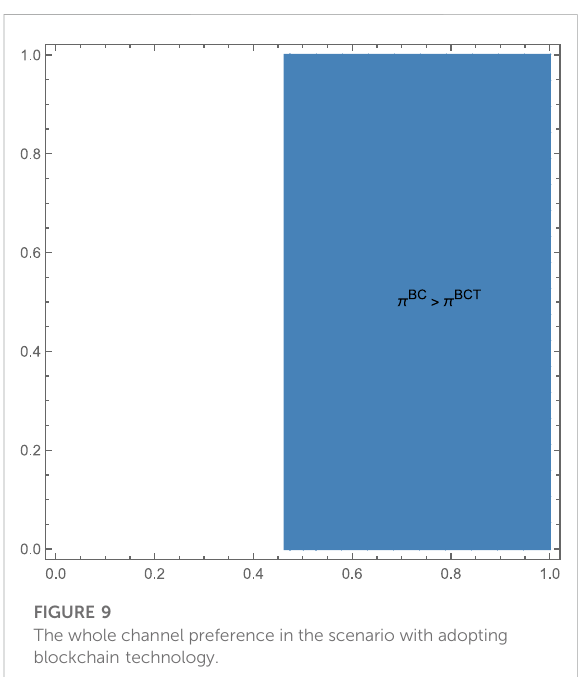
FIGURE 9 The whole channel preference in the scenario with adopting blockchain